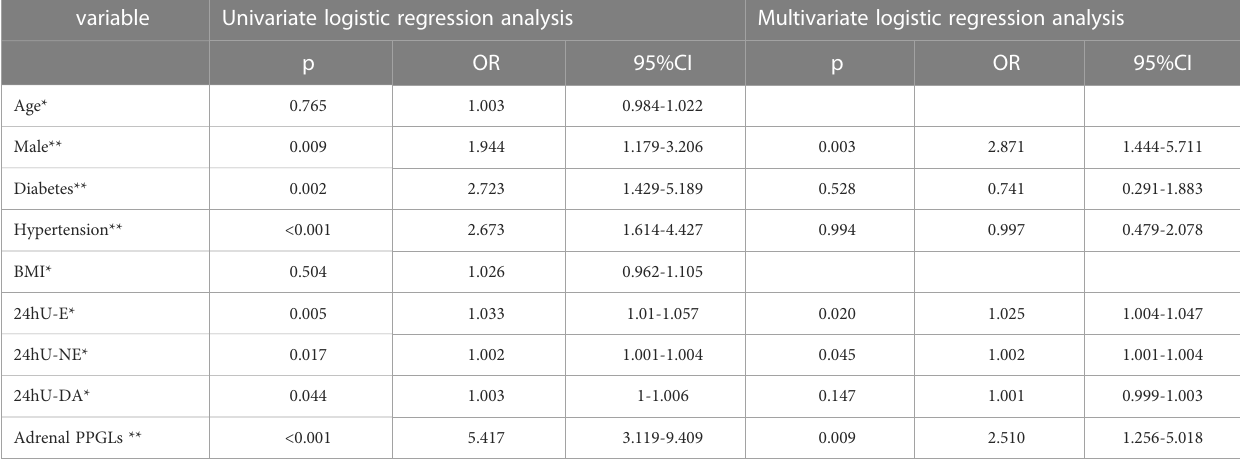
TABLE 3 Results of the logistic regression